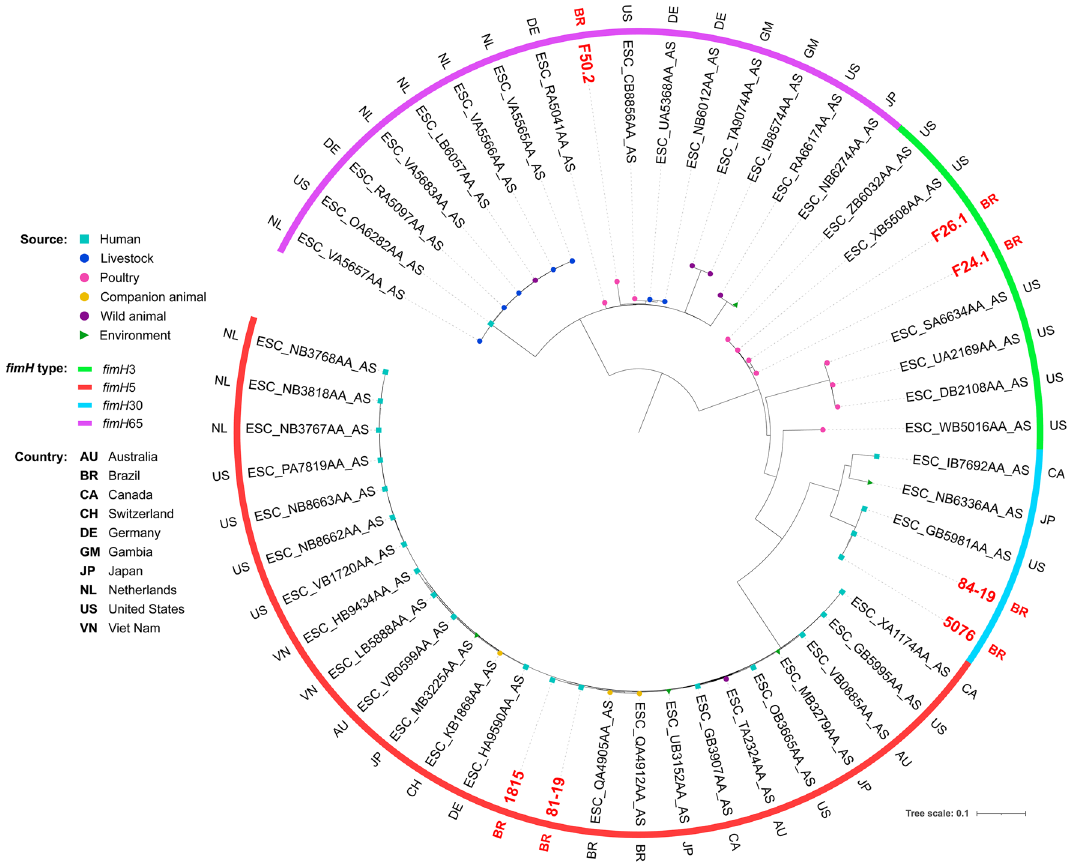
Figure 2. Phylogenetic tree of 54 Escherichia coli ST38 strains, their source, country of collection and fimH